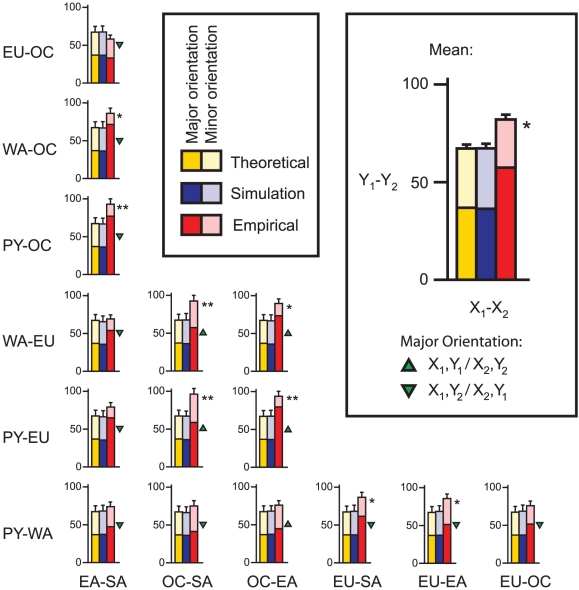
Mean number of parallel divergent SNPs for all fifteen divergence comparisons at a 5% threshold.Groups are abbreviated as in Figure 1A. Theoretical expectations (the threshold squared times the total) are shown in yellow (error bars = theoretical standard deviation; Text S1). Mean results from 1000 simulated samples under the neutral standard model are shown in blue (error bars  =  standard deviation). Observed empirical counts are shown in red (error bars  =  standard deviation among 1000 samples of independent SNPs). For all but one divergence comparison, more parallel divergent SNPs than expected were observed, indicative of parallel adaptation. For each bar, the shading indicates the orientation skew; the darker shade represents the number of SNPs showing the major orientation, and the lighter shade represents the number of SNPs showing the minor orientation. A skew deviating from 50% indicates that each group in the y-axis group pair tended to have relatively similar allele frequencies as a particular group in the x-axis group pair, as indicated by the green triangles. A single asterisk (*) indicates a significant excess of parallel divergent SNPs relative to the standard simulations (≥81 SNPs; p<0.05), while a double asterisk (**) indicates significance both relative to the standard simulations and in Bonferroni-corrected Fisher's exact tests (≥91 SNPs; p<0.05).